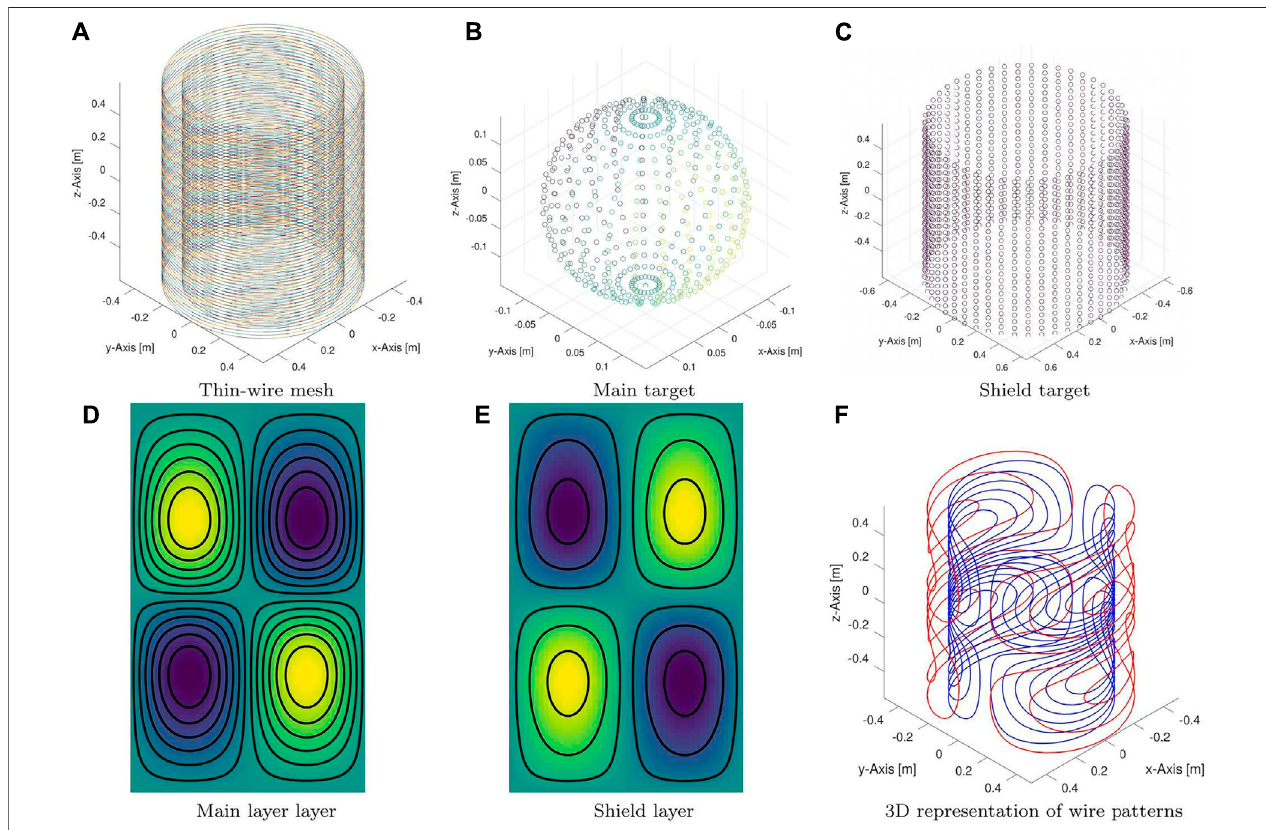
FIGURE4|(A) Thedesignofashieldedgradientcoilhostscurrentsontwoindependentsurfaces.Insuchadesignthegoalistoachieveatarget fi eldincenter (B) , whilesuppressing fi eldsoutsidethecoil. (C) Themagnetic fi eldonanadditionalcylindricaltargetsurface,representingthecryostat,wassettozero.Depictedare (D) the main layer, (E) the shielding layer and (F) a combined representation of the resulting coil